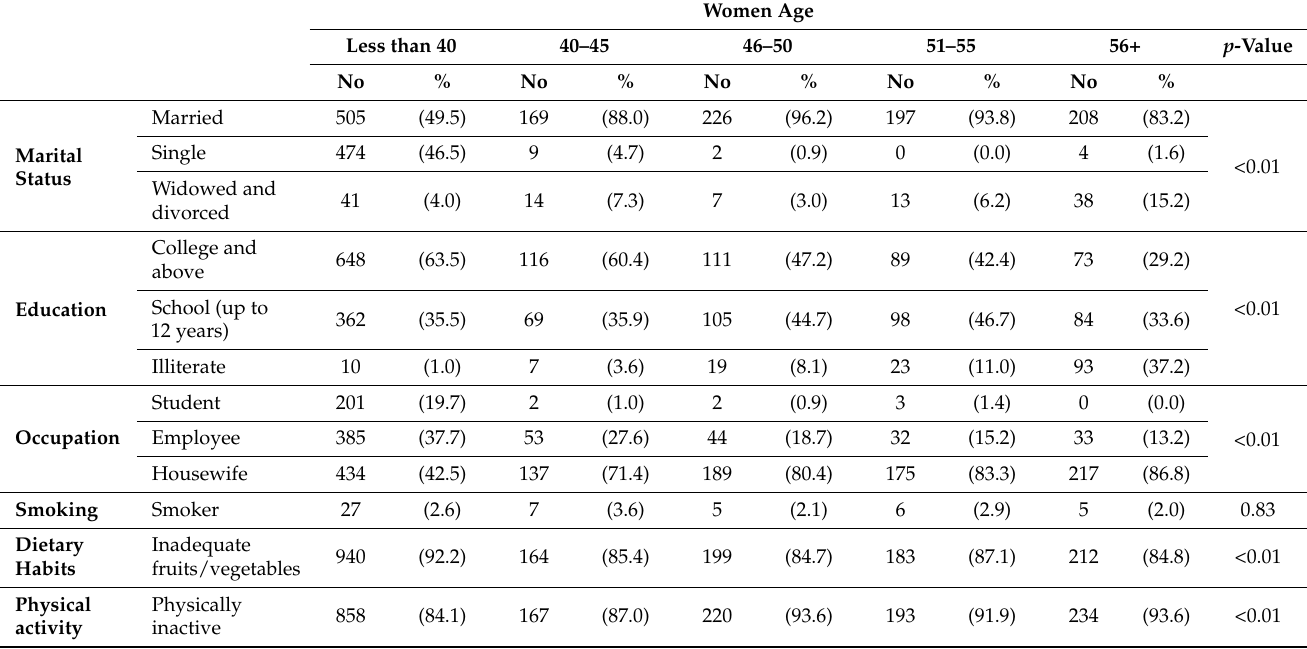
Table 1. Characteristics of the studied sample according to different age